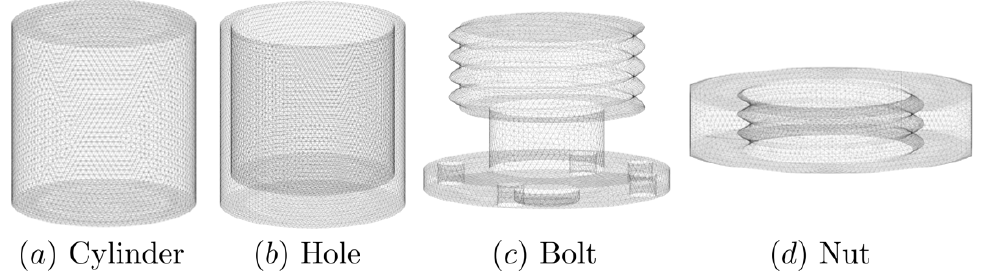
Figure 2. Illustration of the mesh objects: ( a ) cylinder; ( b ) hole; ( c ) bolt; ( d )